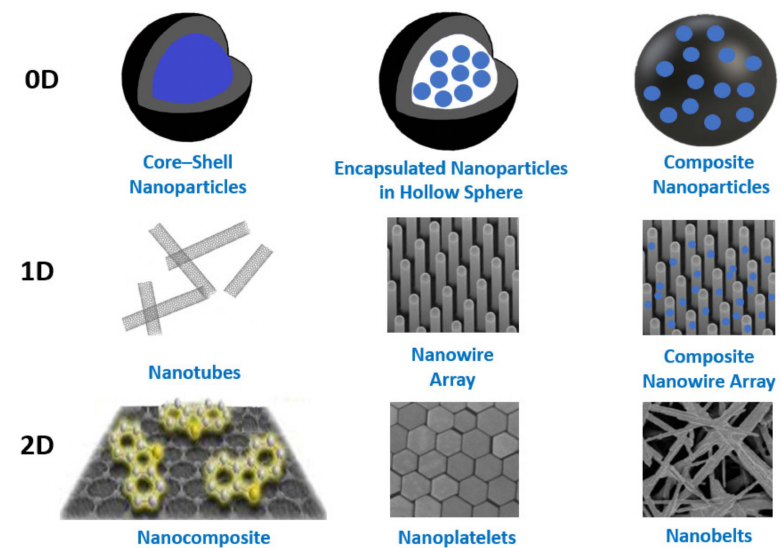
Figure 1. Types of 0D, 1D, and 2D